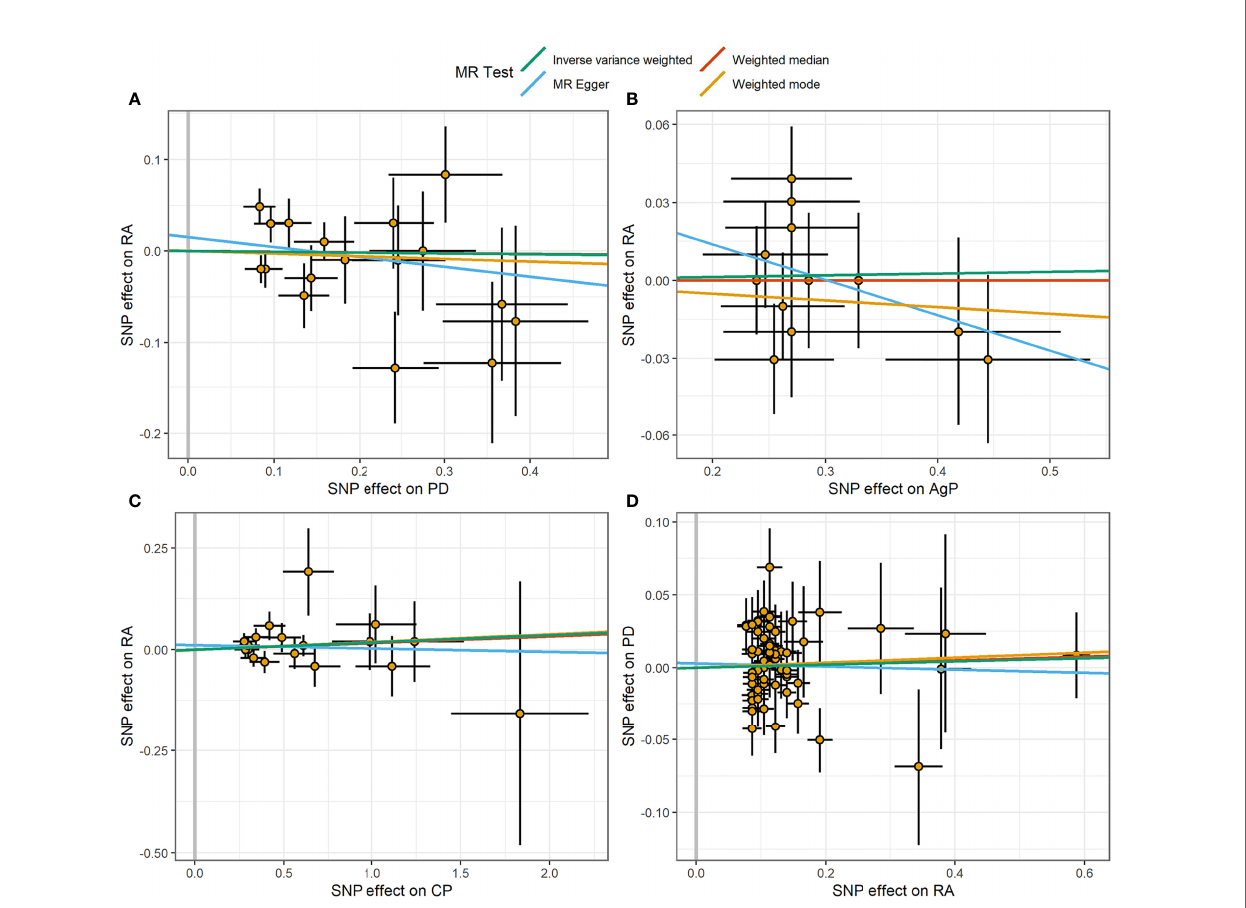
FIGURE 2 | Scatter plot of the causal relationships between RA and PD using different MR methods. (A) Causal estimates for PD on RA. (B) Causal estimates for AgP on RA. (C) Causal estimates for CP on RA. (D) Causal estimates for RA on PD. The slope of each line corresponding to the causal estimates for each method. Individual SNP-effect on the outcome (point and vertical line) against its effect on the exposure (point and horizontal line) was delineated in the